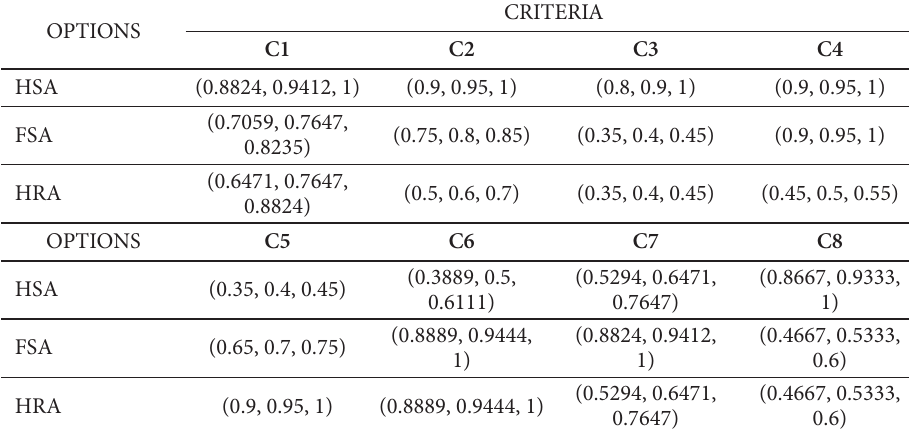
Table 6. Fuzzy normalized decision matrix